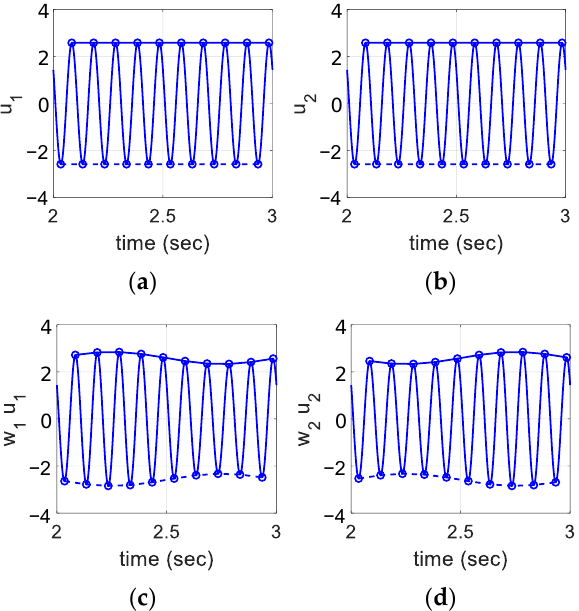
Figure 9. Simulation results when both motors are normal: ( a ) 𝑢 1 , ( b ) 𝑢 2 , ( c ) 𝑤 1 𝑢 1 , ( d ) 𝑤 2 𝑢 2 . As an example, and as shown in Figure 10, the positive (or upper) and negative (or lower) peaks (empty circles) of 𝑤 1 𝑢 1 are analyzed, and the differences between the maximum and the minimum values are calculated. We define this as a pattern variation. Pattern variations are recorded for 𝑤 1 𝑢 1 (A in Table 2) and for 𝑤 2 𝑢 2 (B in Table 2). In the table, U denotes the pattern variation calculated by using the upper peaks, and L denotes the pattern variation of the lower peaks.